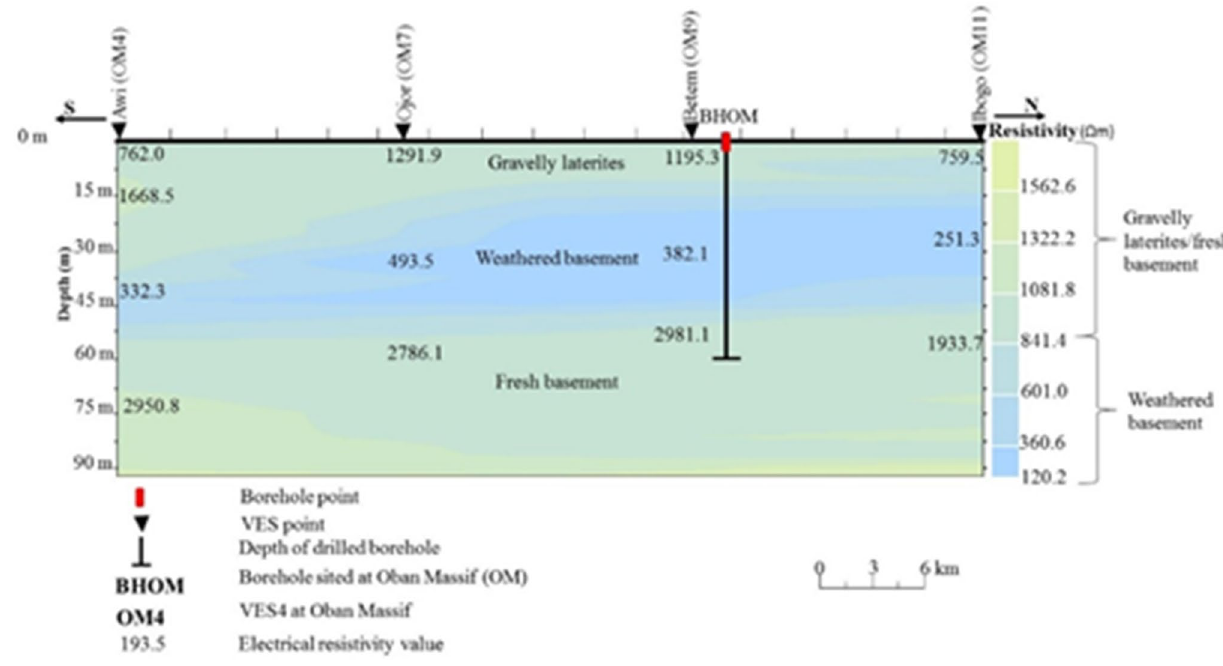
Fig. 8 Electro-stratigraphic section oriented N–S in the OM